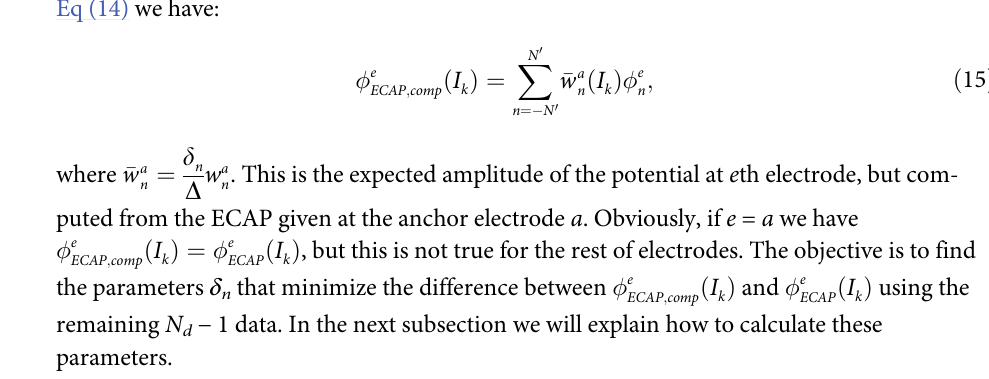
PLOS Computational Biology | https://doi.org/10.1371/journal.pcbi.1010134 May 27,